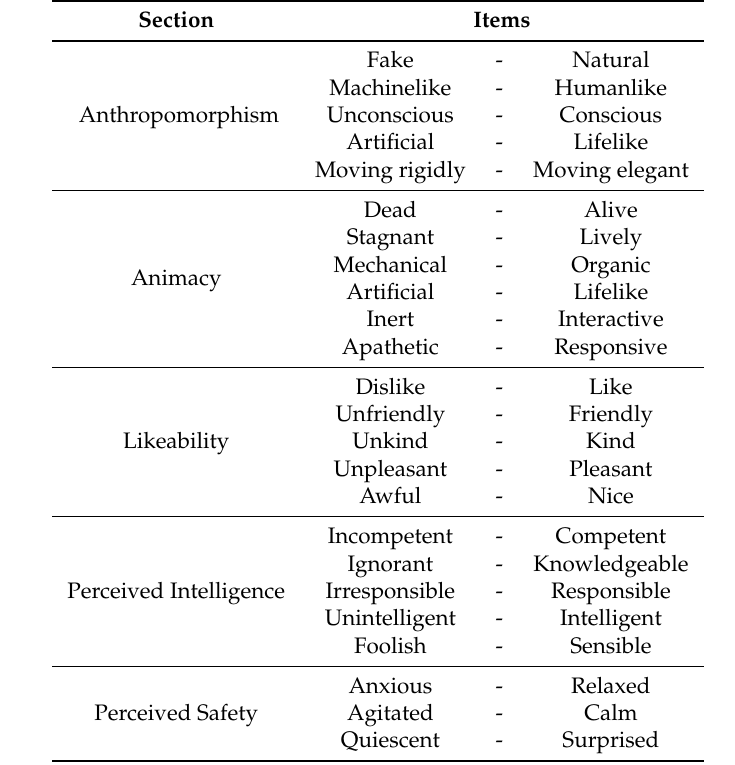
Table 5. The Godspeed Questionnaire Series.